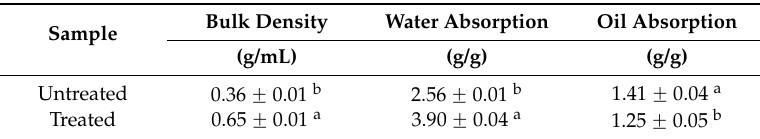
Means with different letters in same column differ significantly ( p < 0.05), n =